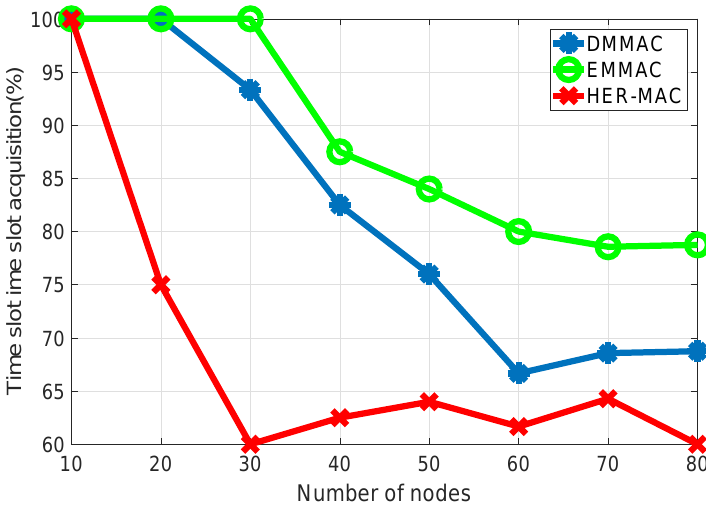
Figure 6. Time slot acquisition